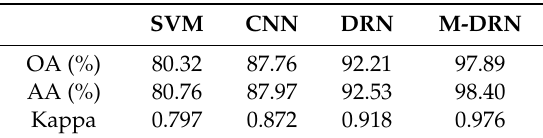
Table 5. Performance metrics for ground object classification using the fused features and each of the SVM, CNN, DRN, and M-DRN classifiers.